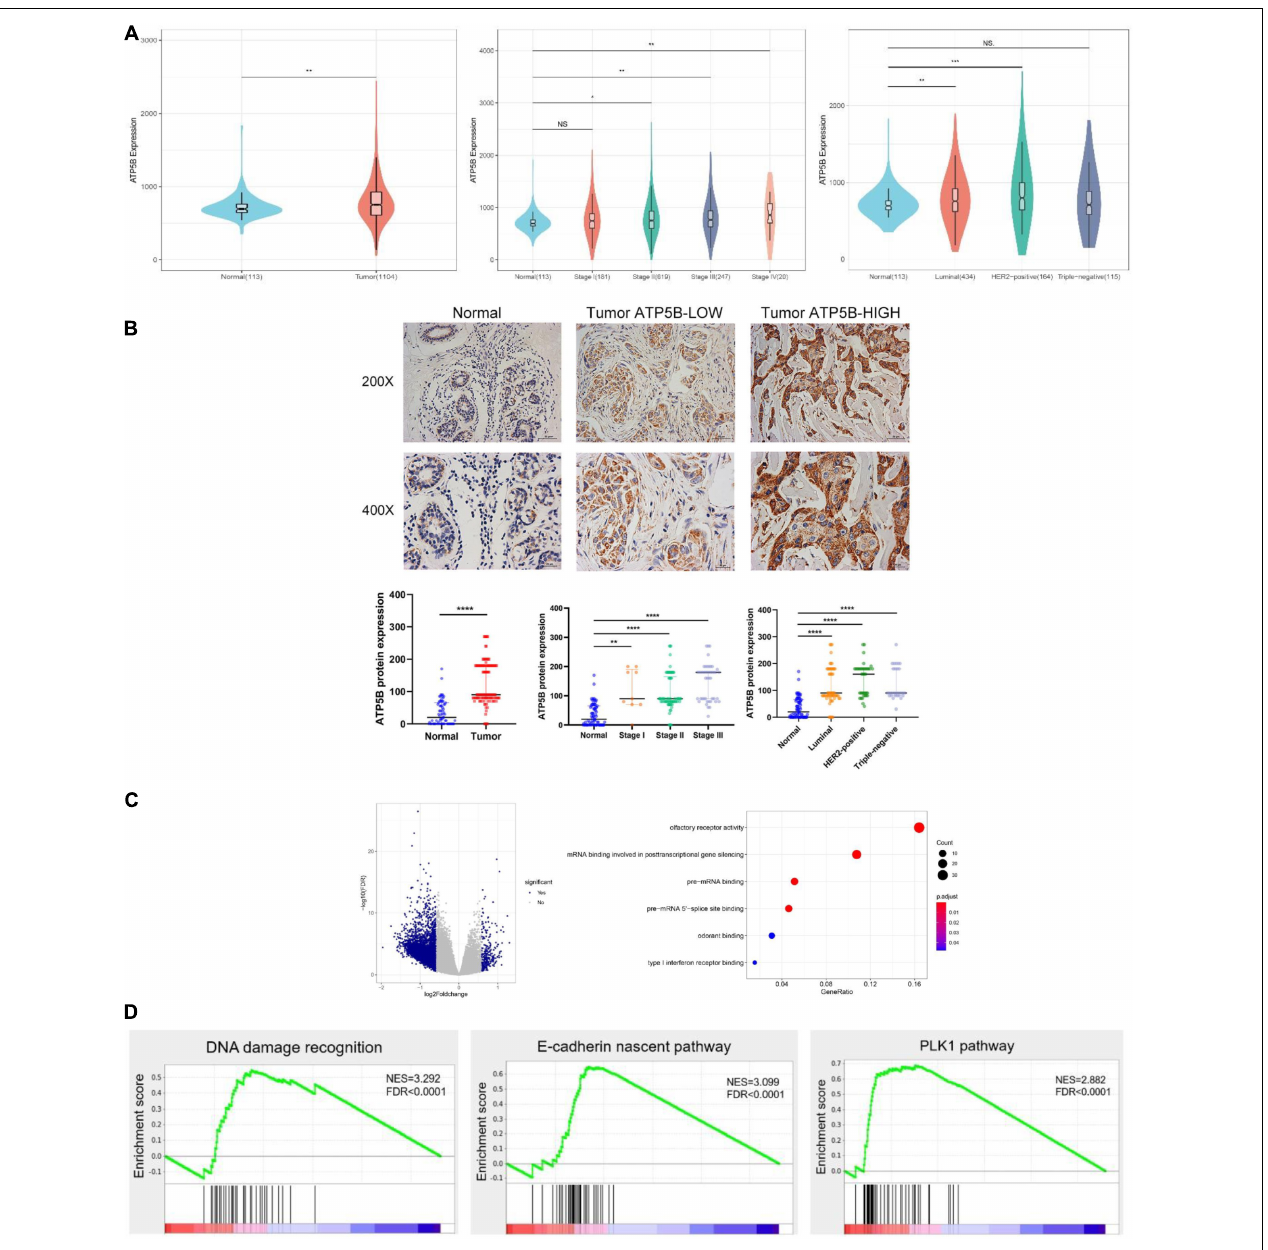
FIGURE 3 | ATP5B expression and functional enrichment in breast cancer. (A) Comparison of ATP5B mRNA expression between tumors and normal tissues, stages I–IV, and each subtype, including luminal, HER2 positive, and triple-negative cancers, in the TCGA BRCA data. (B) Representative IHC staining of the control, low and high expression of ATP5B protein in breast cancer; scale bar, 20 µ m. The relative protein level of ATP5B in breast cancer tissues compared with adjacent normal tissue, stages I–III, as well as the three molecular subtypes. The data represent the median with interquartile range. (C) Volcano plot of differentially expression gene profiles between the ATP5B-high and ATP5B-low groups. The cut-off points were set at |log2(fold change)| ≥ 1.5 and FDR < 0.05. GO annotation analysis of the overlapping genes in molecular function. Each circle represents a term, and its size represents the counts of the involved genes. (D) The three enrichment plots from the GSEA, including DNA damage recognition, E-cadherin nascent pathway and the PLK1 pathway.